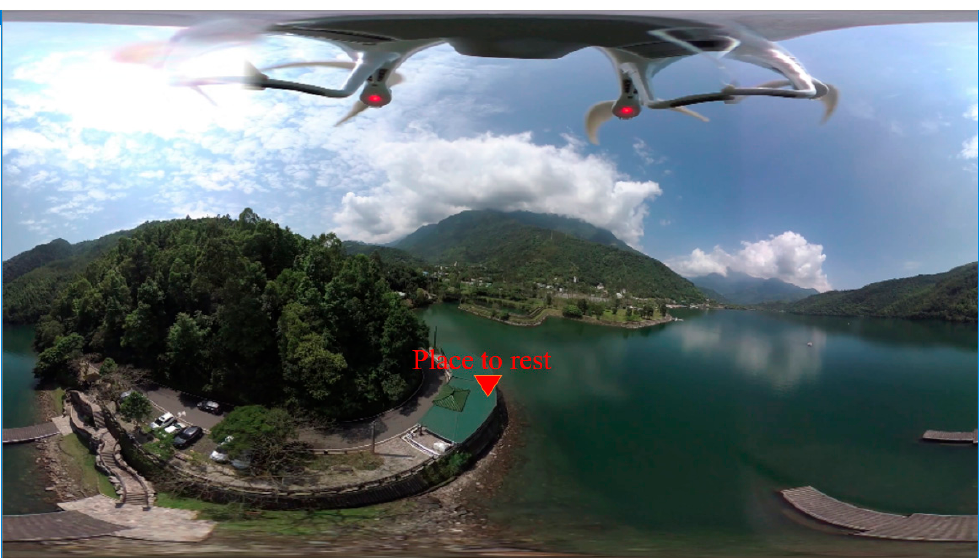
Figure 1. Tagging an Augmented Reality (AR) marker on a physical target in 360-degree videos.